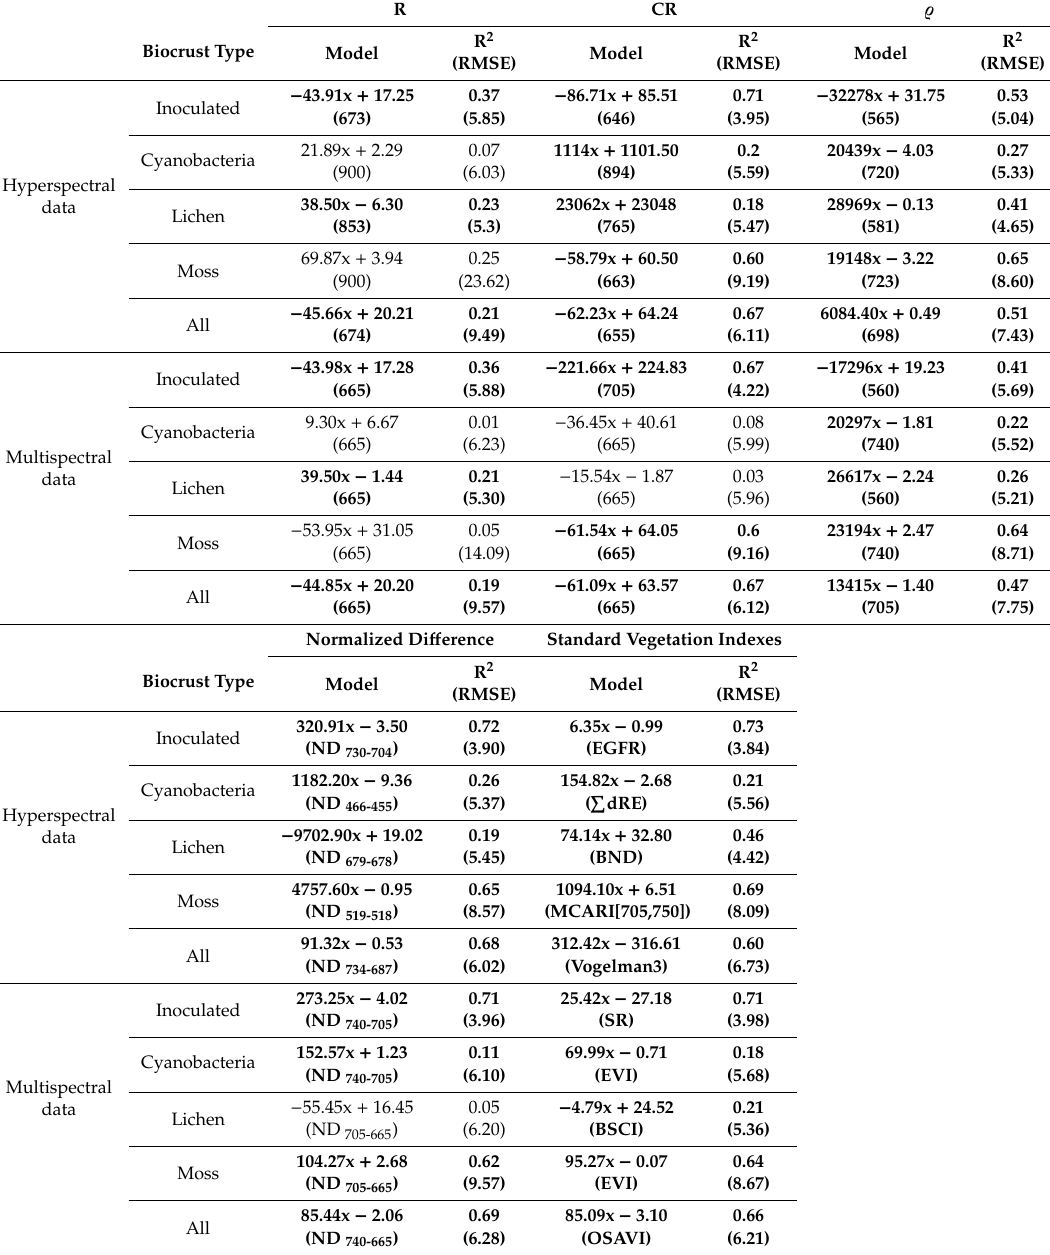
Table1. Performanceofthereflectance(R),continuumremoval(CR),firstderivativeofthereflectance( (cid:37) ), normalized di ff erence (ND), and standard vegetation indexes for predicting chlorophyll a concentration in di ff erent biocrust types. The regression model for the band, band combination, or standard vegetation index (within parenthesis) with the highest coe ffi cient of determination (R 2 ) and the lowest root mean square error (RMSE) is shown for each biocrust type. Bold values represent significance at 95% confidence interval or p <